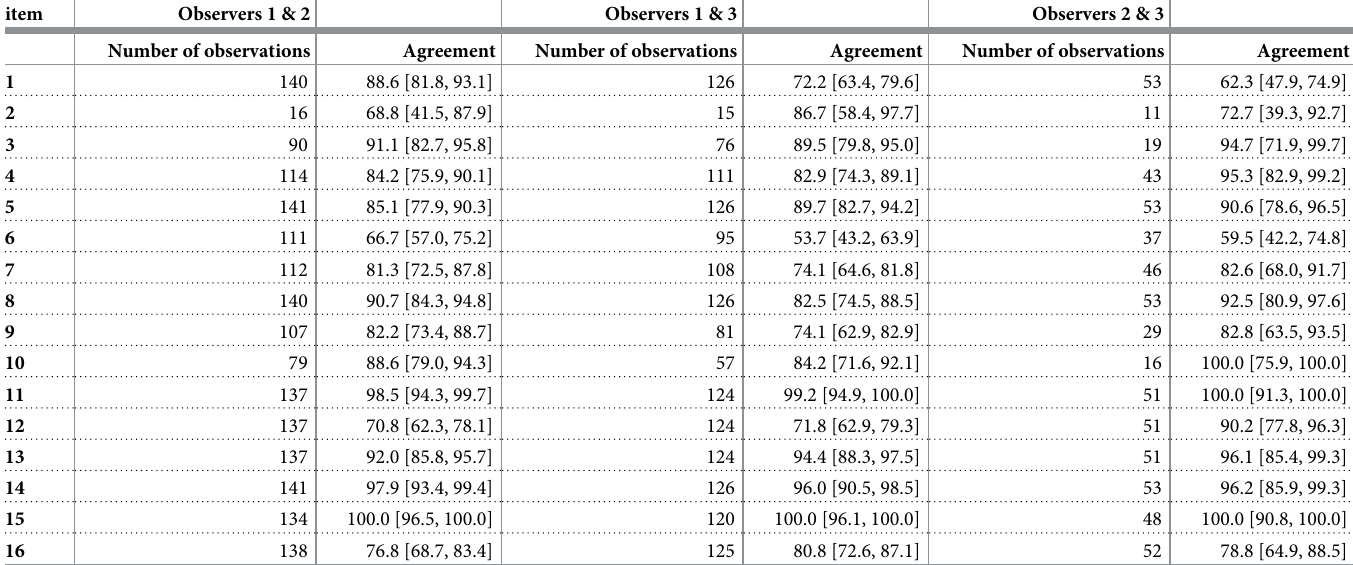
Table 3. Second step of the assessment of observer agreement: Pairwise percent agreement (with 95% confidence interval) on categories 1–5 when there was a con- sensus that the item was